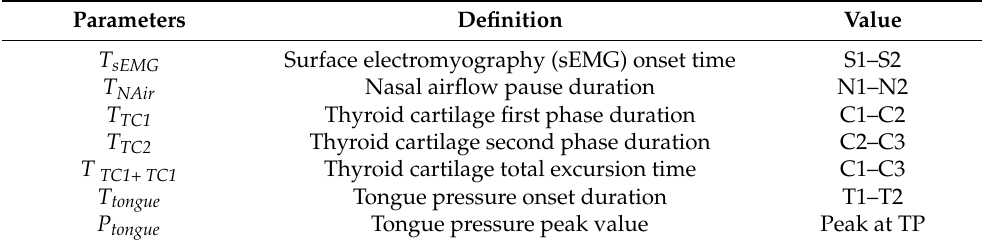
Table 2. Parameters in the multisensor swallowing